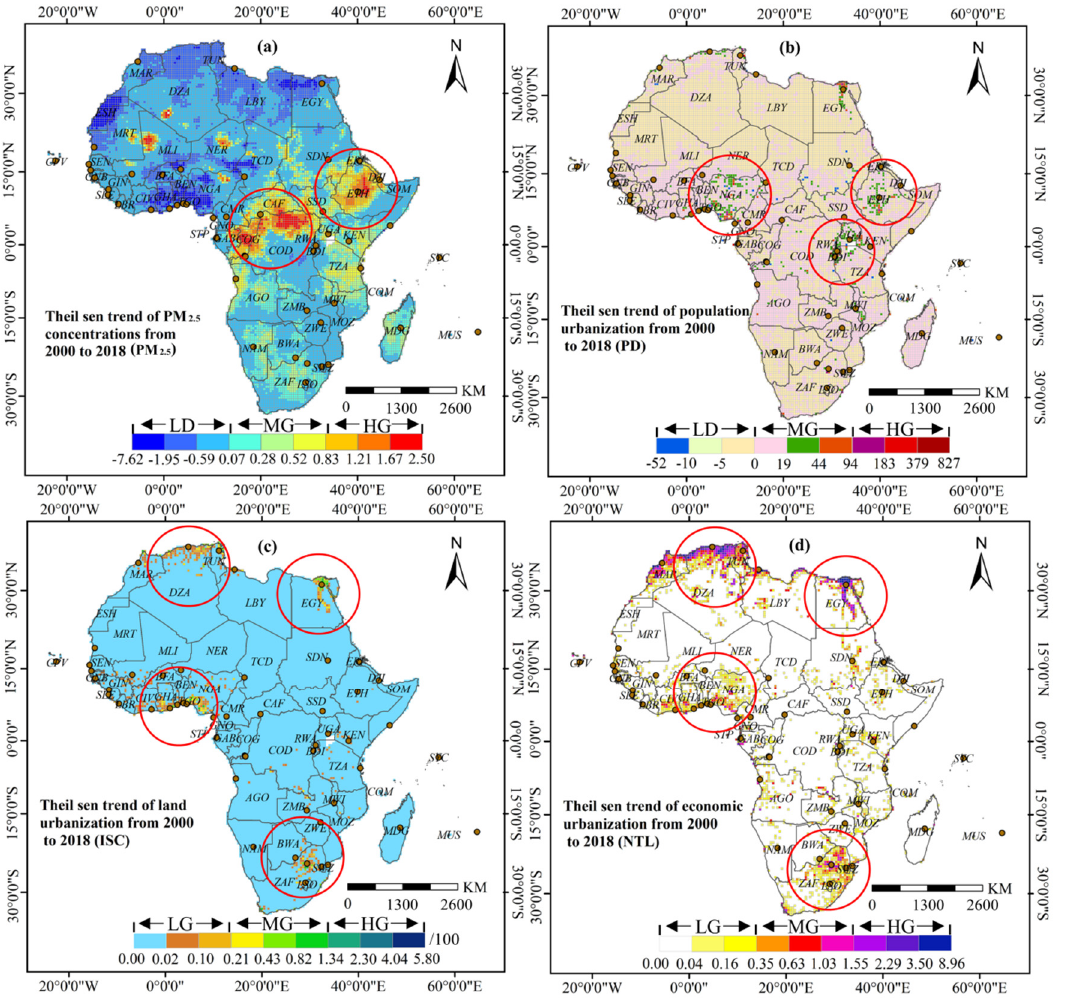
Figure 7. Spatial evolution trend of PM 2.5 concentrations ( a ), population urbanization ( b ), land urbanization ( c ), economic urbanization ( d ) in African countries from 2000 to 2018.